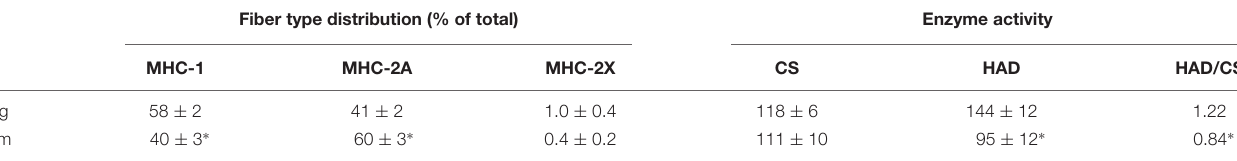
TABLE 2 | The profile of myosin heavy chains and enzyme activities in the arm ( triceps brachii ) and leg ( vastus lateralis ) muscles of elite cross-country skiers ( n = 10).